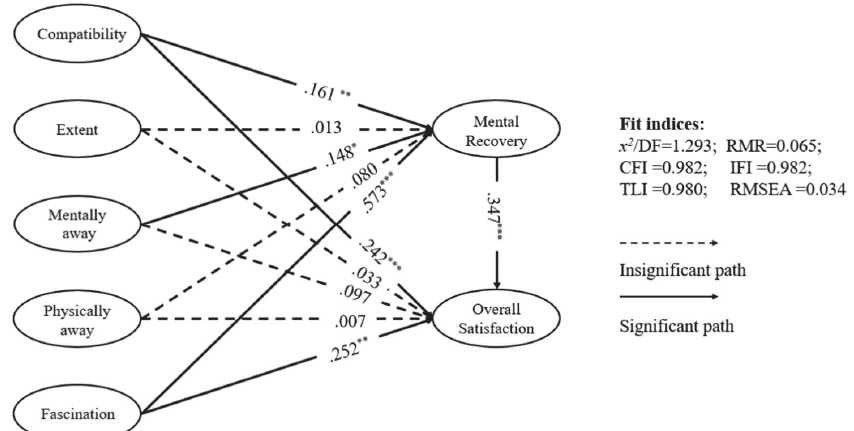
Fig. 1. model path coefficient. * significant at p<.05; ** significant at p<.01; *** significant at p<.001